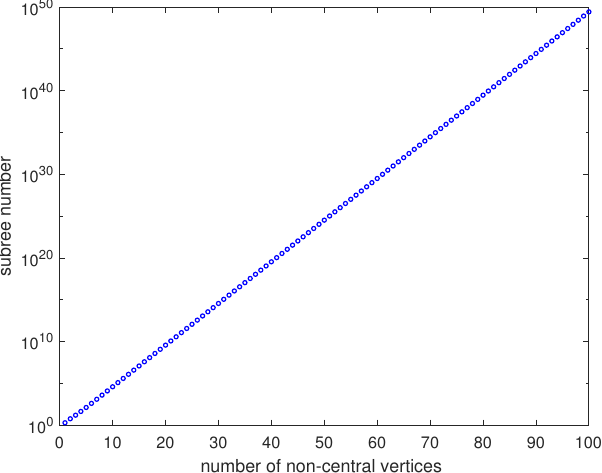
that contain the vertex c 1 , in semi-log(Log-Y) 1, j